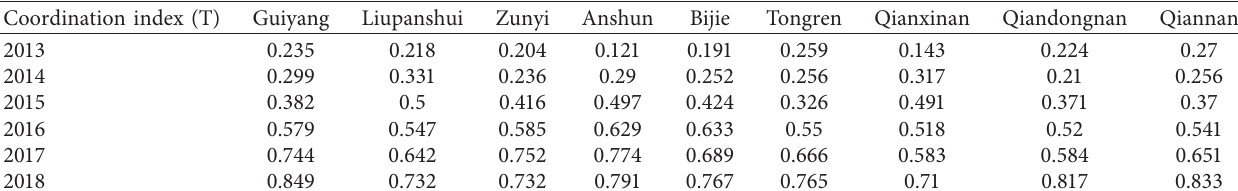
Table 4: Coordination indices of each prefecture in Guizhou during 2013–2018. Coordination index